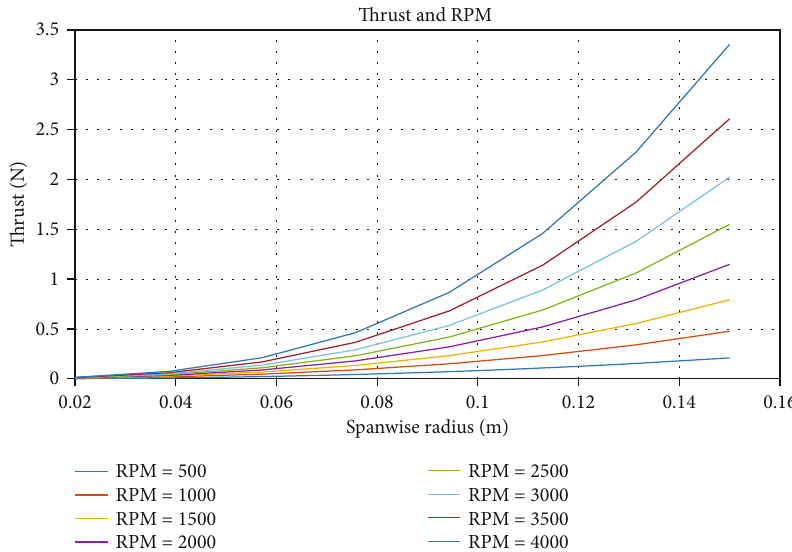
Figure 3: Generation of thrust for the blade designed to operate at 4,000m altitude.